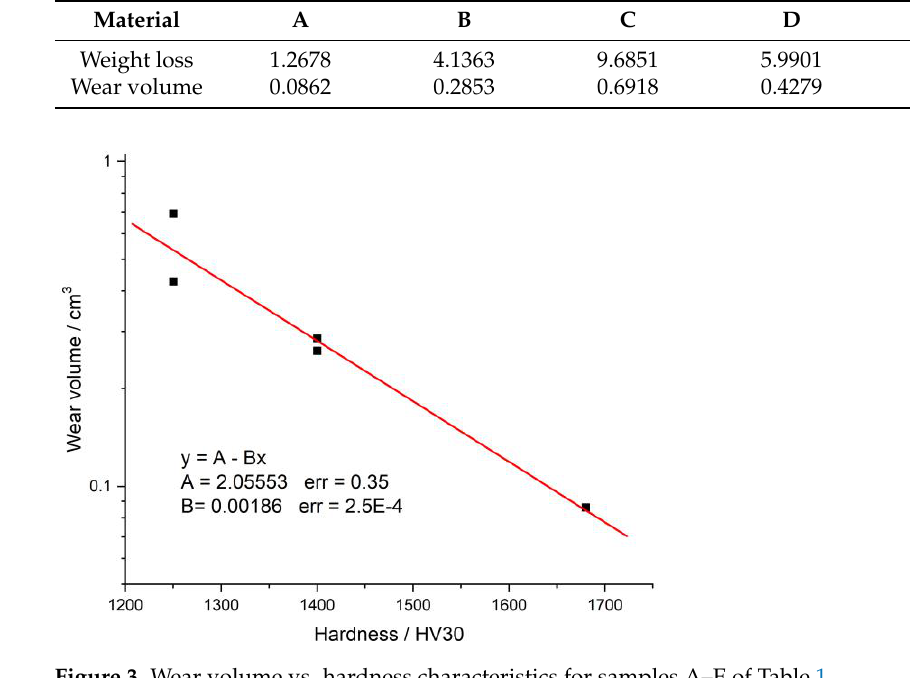
Figure 3. Wear volume vs. hardness characteristics for samples A–E of Table 1.